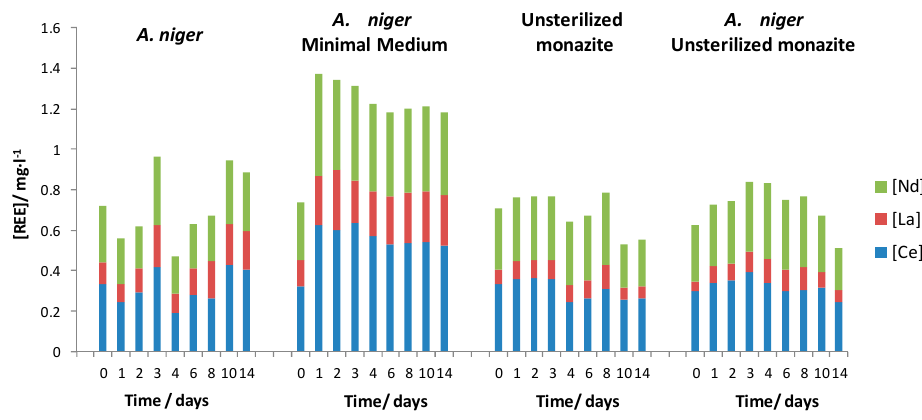
Figure 9. Total concentration of rare earth elements, cerium (Ce), lanthanum (La), and neodymium (Nd) bioleached during the experiments under different conditions.